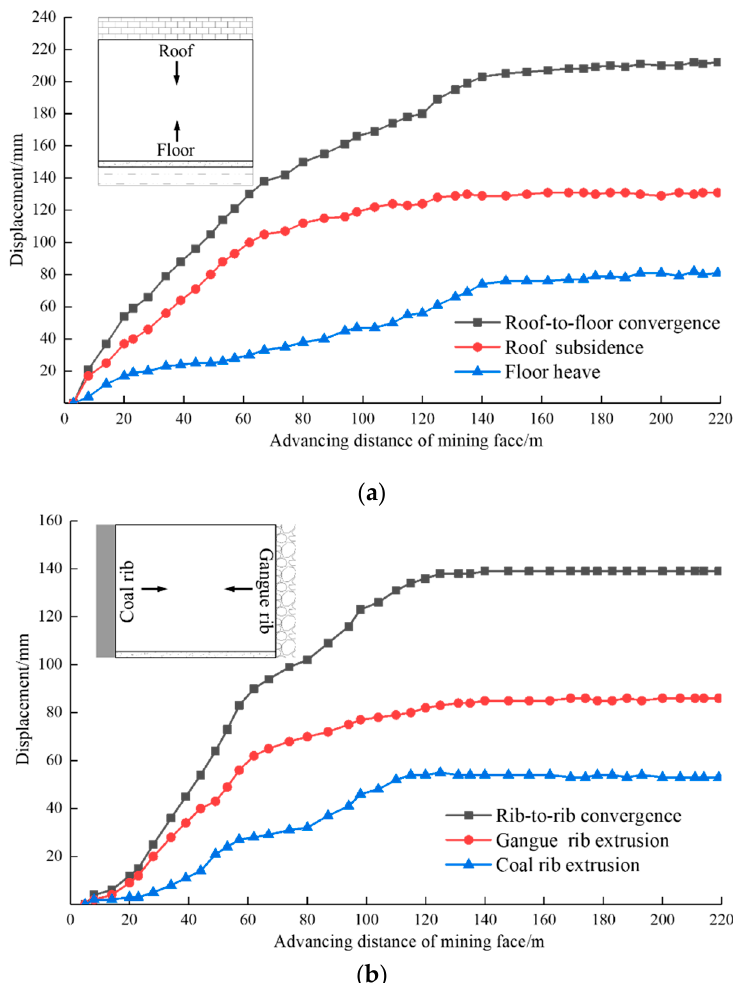
Energies 2019 , 12 , x FOR PEER REVIEW Figure 14. Gob-side entry deformation. ( a ) Vertical displacement; ( b ) horizontal displacement.